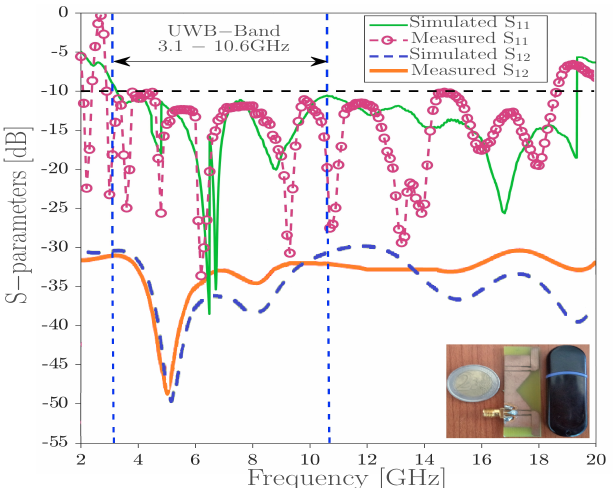
FIGURE 5: Measured and simulated S -parameters of the proposed MIMO UWB CPW -fed bent antenna